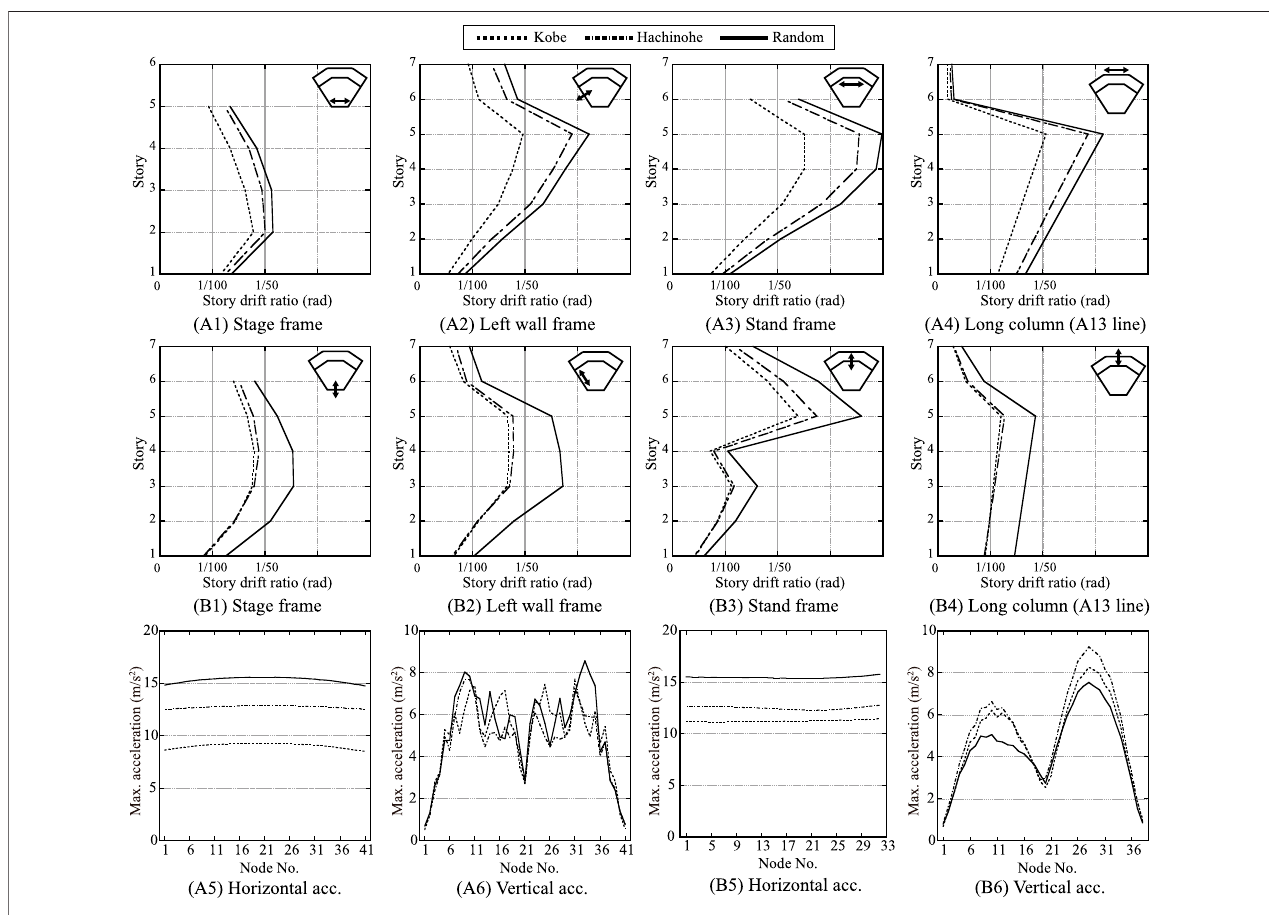
FIGURE 3 | Seismic response of the BF model: (A) X-directional input, (B) Y-directional input.